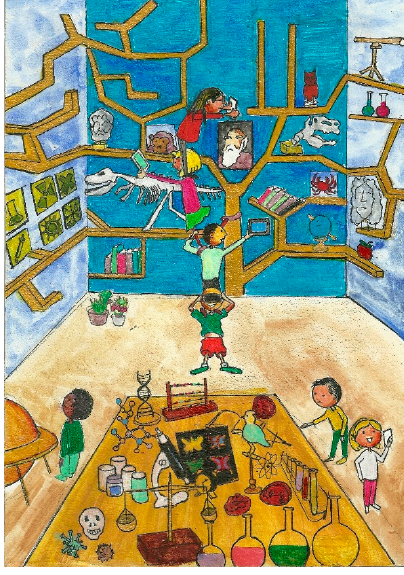
Figure 3. Blending the tangible and digital worlds through the curiosity cabinet (design: Stelios Christoforakis and Charoula Chrysoglou).